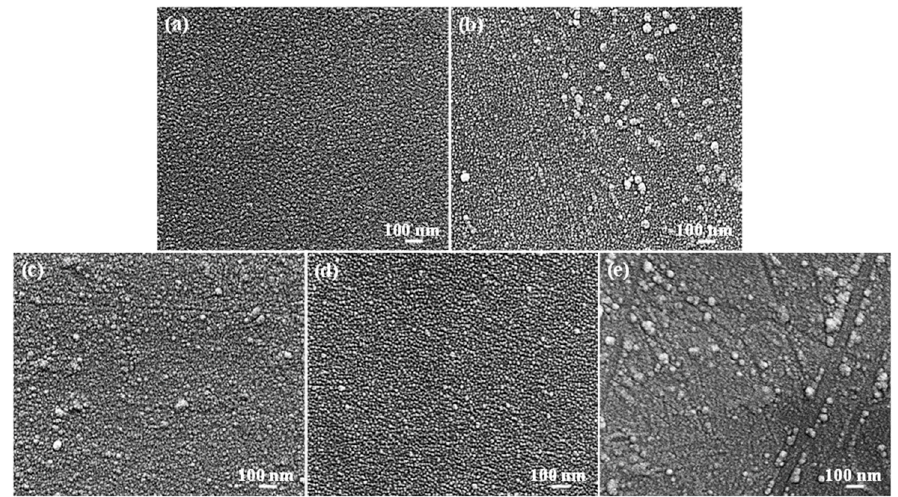
Figure 2. The SEM micrographs of investigated samples: ( a ) control TiO sample, ( b ) HDPA-SAM / TiO sample, ( c ) NDPA-SAM / TiO sample, ( d ) PUA-SAM / TiO sample, and ( e ) PHA-SAM / TiO sample.